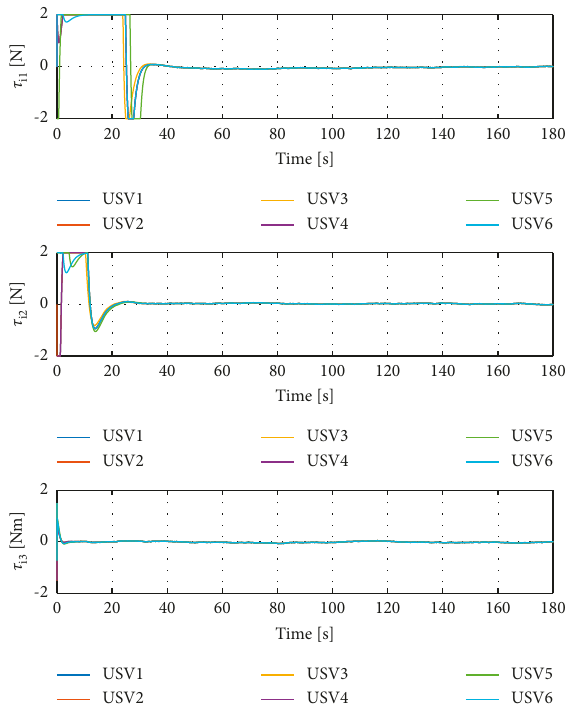
Figure 6: The control input ( τ